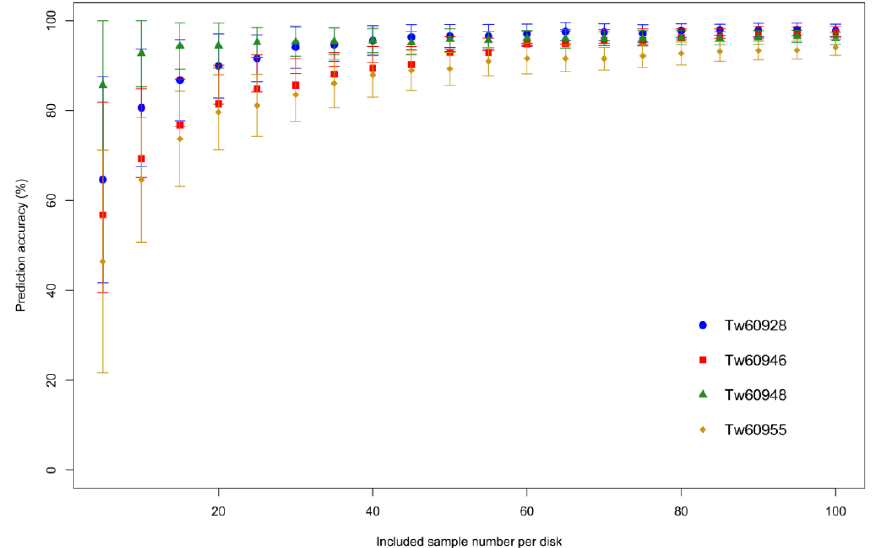
Figure 2. Average prediction accuracy for a random ring sample to be classified in the correct Pericopsis elata disk through random forest with five-fold cross-validation and increasing sample number per disk (from five to 100 samples, per five samples, with 100 runs per sample number). The bars indicate the standard deviation on the average prediction accuracy per 100 runs.